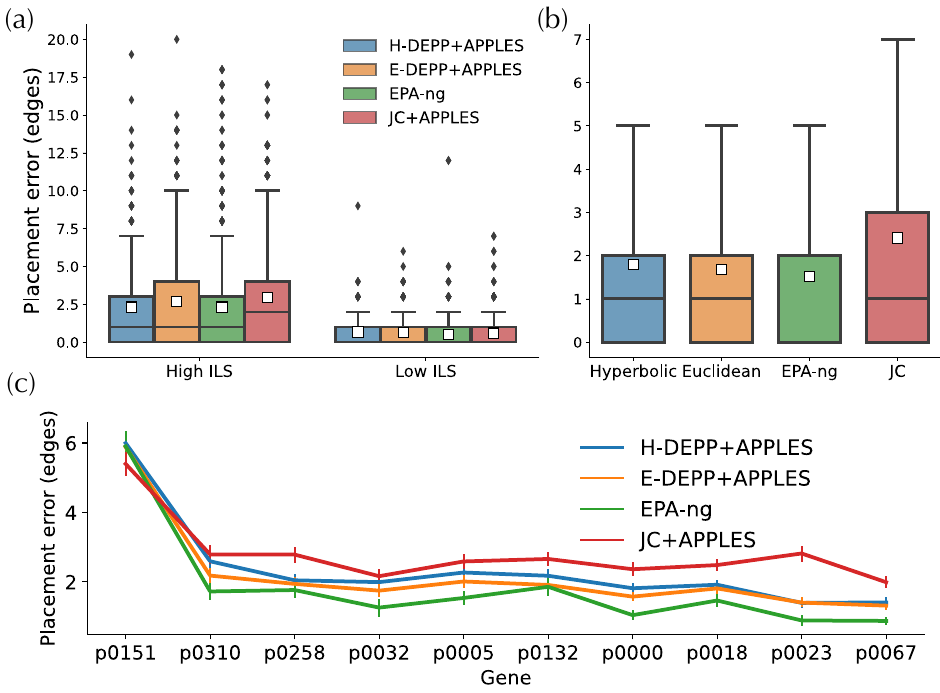
Figure 8. Phylogenetic placement for ( a ) simulated data ( b ) WoL 16S data ( c ) WoL marker genes data. The white squares in the boxplots represent the average placement